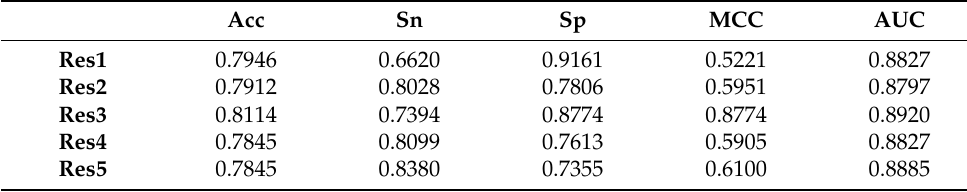
Table 2. Performance of different SeqPoseDict on the same test set. The first row gives the values of the five performance metrics—including Sn, Sp, MCC, AUC, and Acc. The first column is different